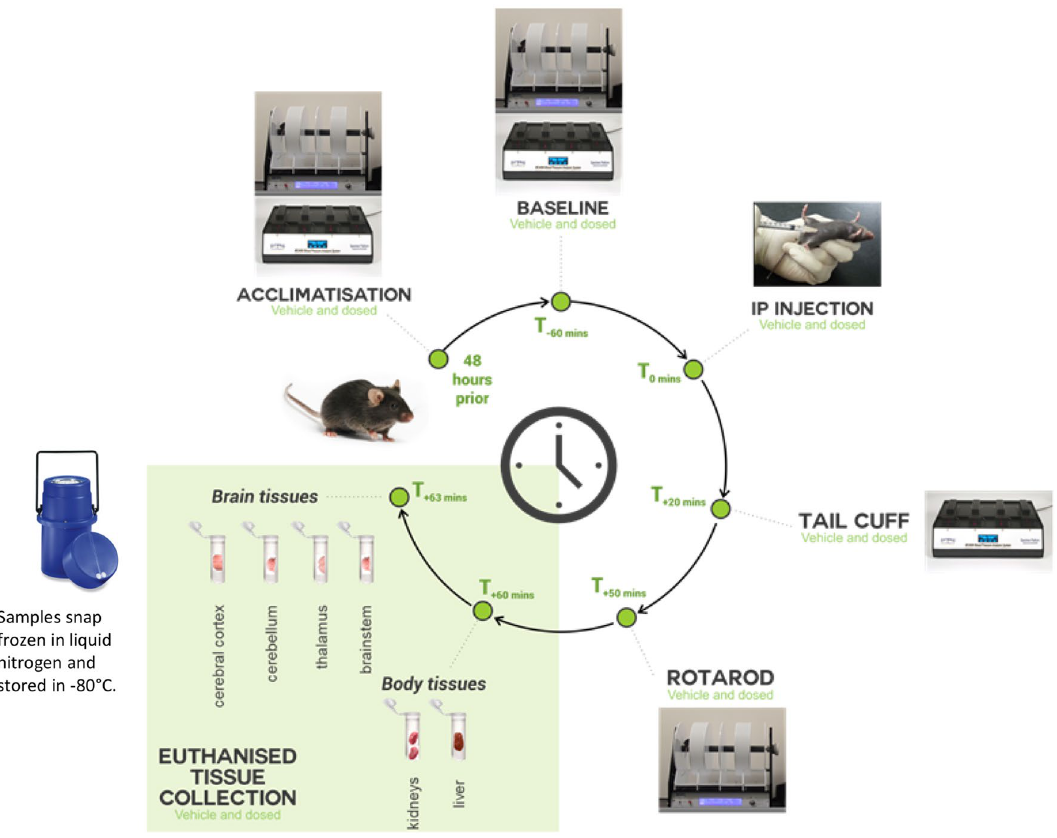
Figure 1. Experimental design of mouse bioassay for ergot alkaloid